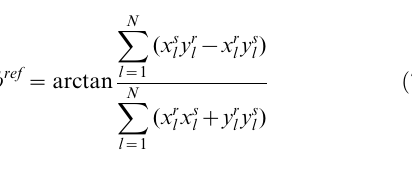
Table 1. Registration results for the proposed method and two reference registration methods.